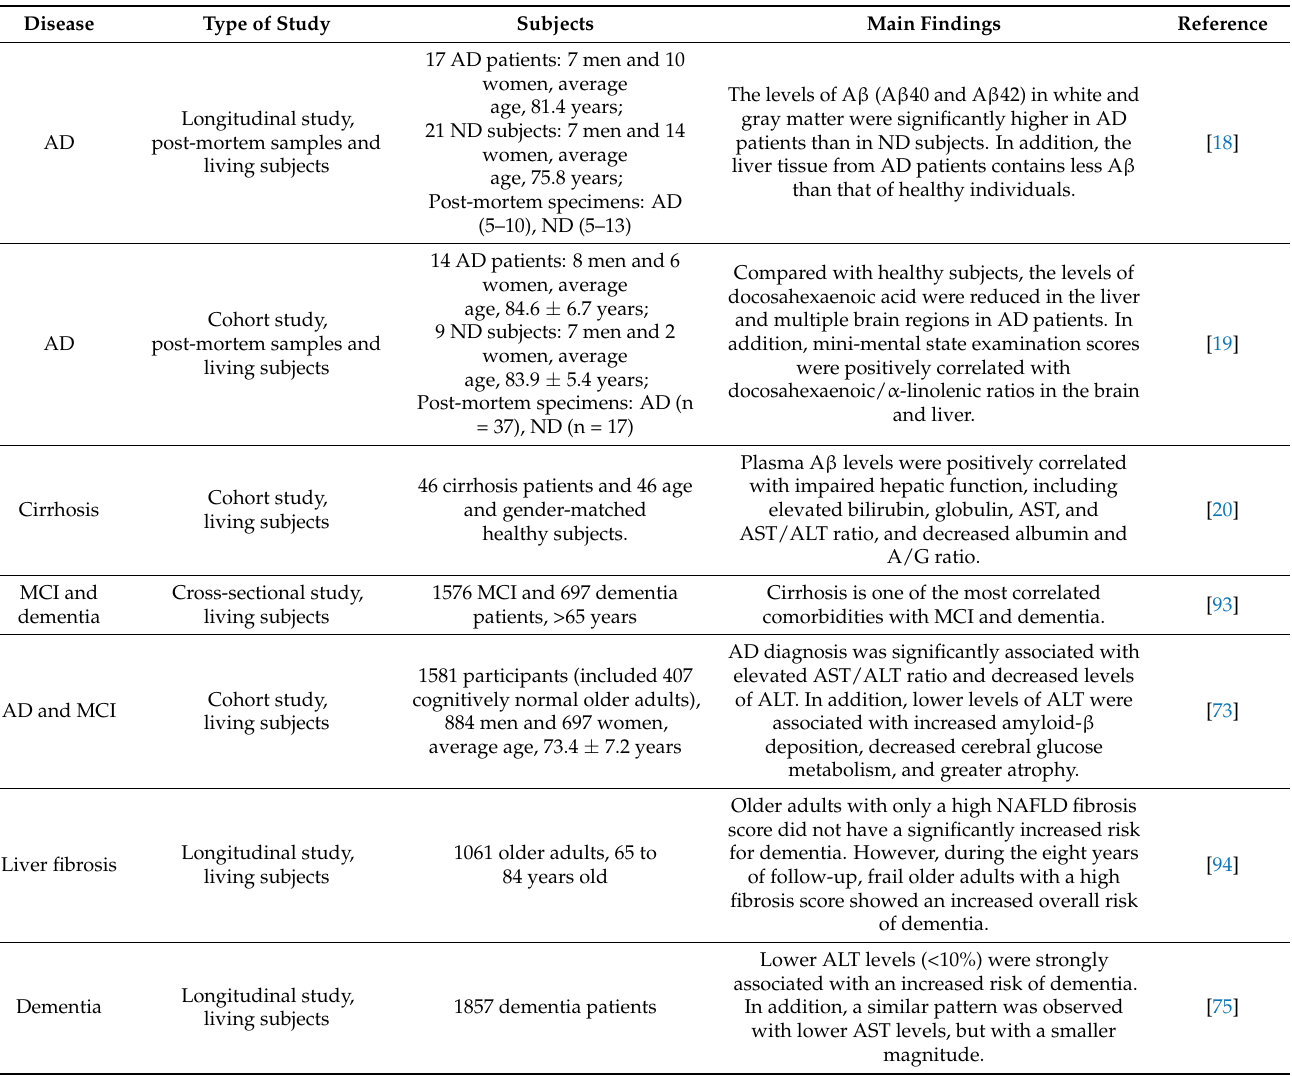
Table 2. Clinical data on the crosstalk between liver dysfunction and AD or